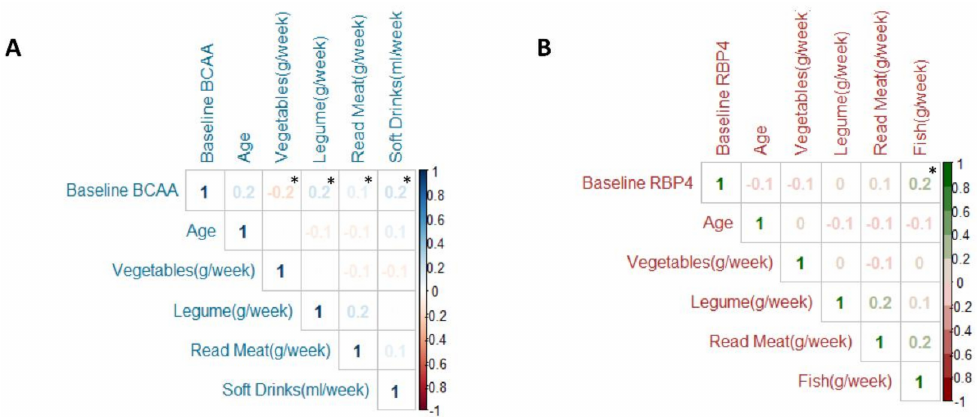
Figure 1. Correlation between baseline levels of BCAA ( A ) or RBP4 ( B ) with anthropometric and diabetes markers (N = 266). BCAAs: branched amino acids; BMI: body mass index; HbA1c: glycated hemoglobin; HOMA: homeostatic model assessment. Correlation analyzed was performed by Pearson’s tests. * Denotes significant di ff erence with p < 0.05.